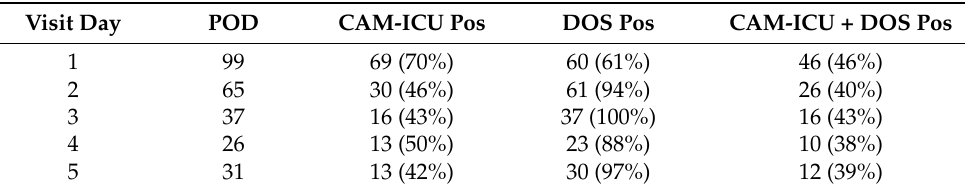
Table 5. Comparison of positive POD tests in ICU and